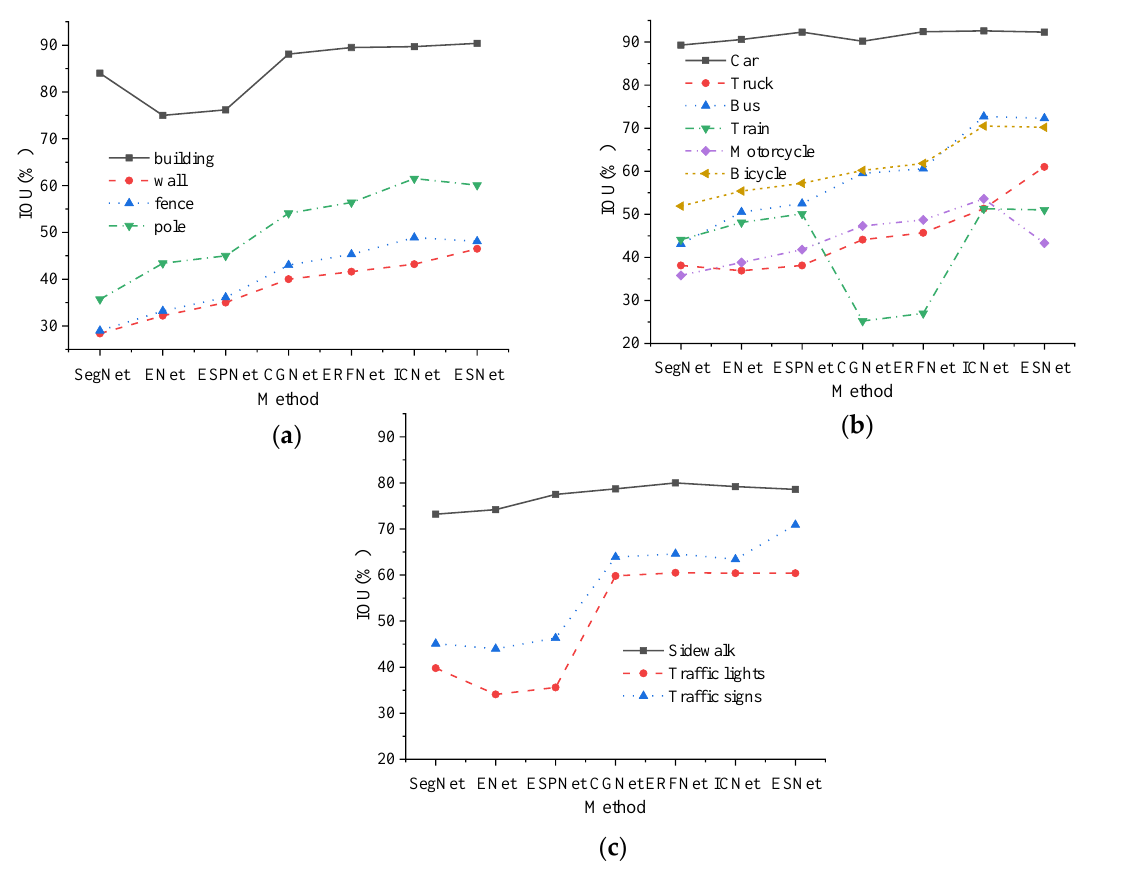
Figure 15. Comparison of recognition results of various segmentation models: ( a ) recognition results of various buildings; ( b ) recognition results of various traffic facilities; ( c ) recognition results of various traffic signs.